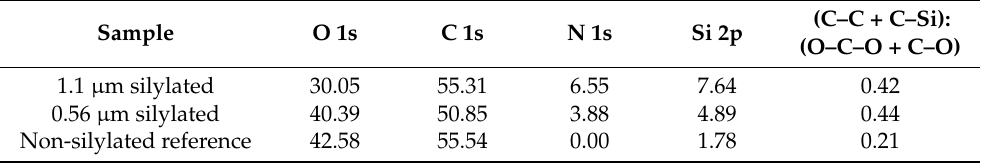
Table 1. Chemical composition of the CNF filament surfaces. Fractions of elements in percentages (%) on the silylated and non-silylated filament surfaces according to XPS analysis.